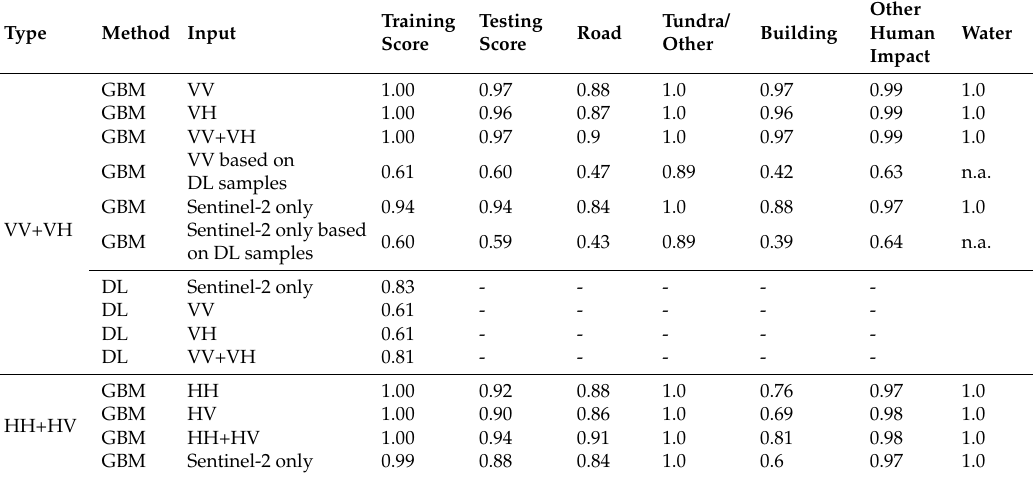
Table 4. Model efficiency assessment results (F1-score) for the Gradient Boost Machine (GBM) and the Deep Learning (DL) algorithm. Separation by polarization combination of Sentinel-1 data (V-vertical, H-horizontal). The column “Tundra/other” reflects the tundra class in case of GBM-specific training data both waterbodies and tundra in case of use of DL-specific